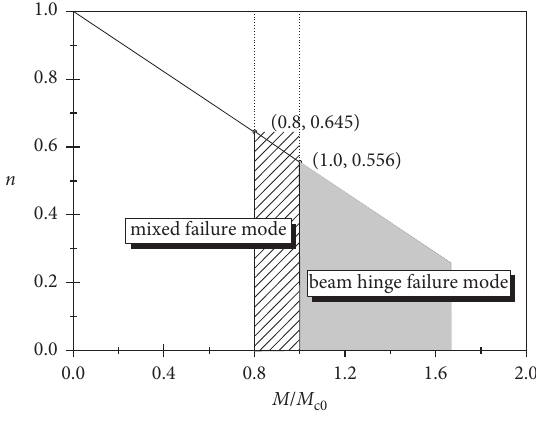
Figure 9: M - N interactive